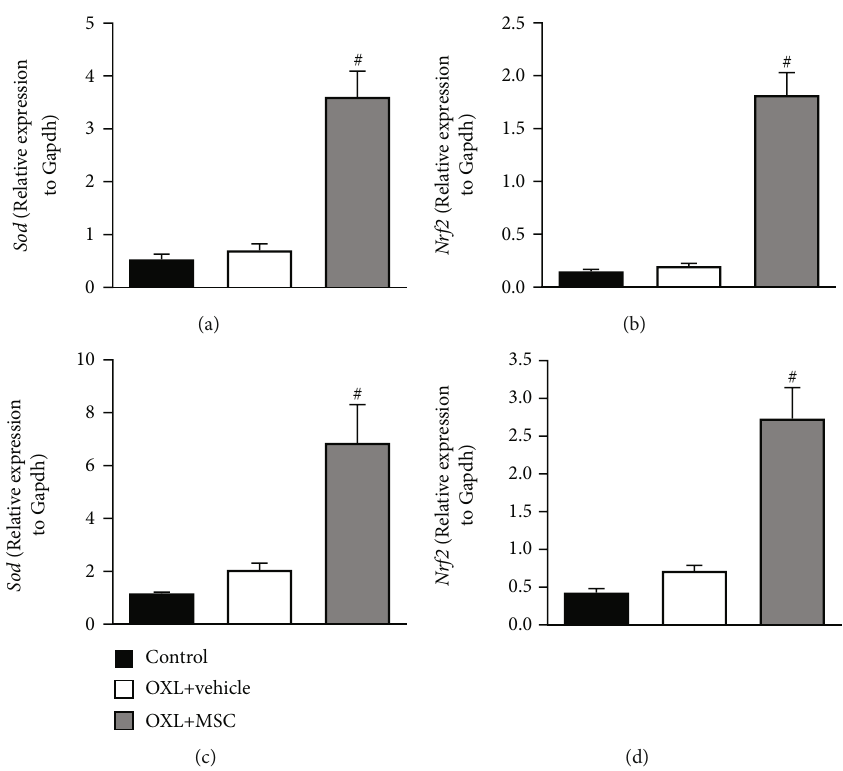
Figure 4: E ff ect of MSC on the expression of the antioxidant factors, Sod and Nrf2, in the sciatic nerve and dorsal root ganglia of mice with OXL-induced chronic neuropathy. Two weeks after the OIPN model induction, mice were treated with 1 × 10 6 MSC (OXL+MSC) or vehicle (OXL+saline) by endovenous route. Control group received 5% dextrose instead of OXL. The levels of mRNA in the sciatic nerve (a, b) and DRG (c, d) were measured by RT-qPCR 4 weeks after treatment. Target gene expression is represented normalized by the internal control gene, Gapdh . Data are expressed as means ± standard deviation ; n = 6 mice per group. # Statistical signi fi cance relative to the OXL+vehicle group ( p < 0 : 01 ), as determined by one-way ANOVA followed by Tukey ’ s multiple comparison